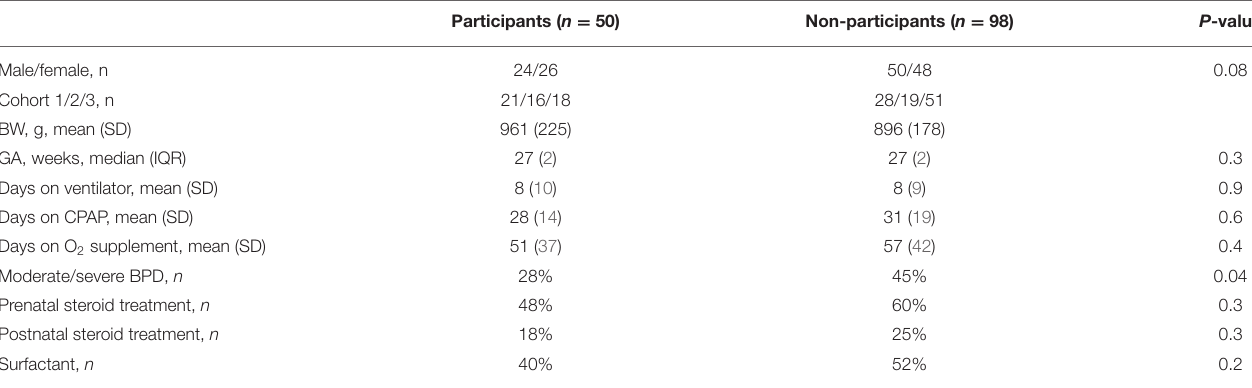
TABLE 4 | Characteristics of participants and non-participants born very preterm or with extremely low